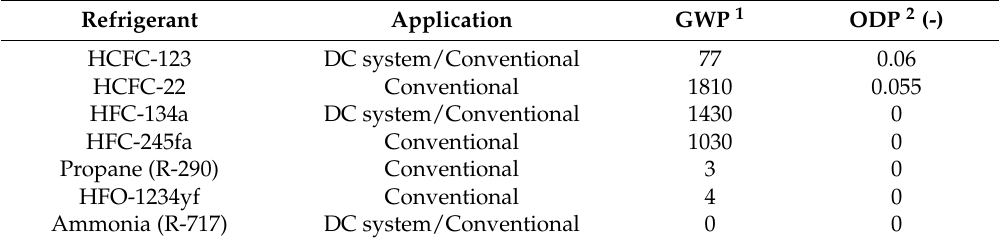
Table A4. GWP and ODP values of commonly used refrigerants in conventional air-conditioning and DC